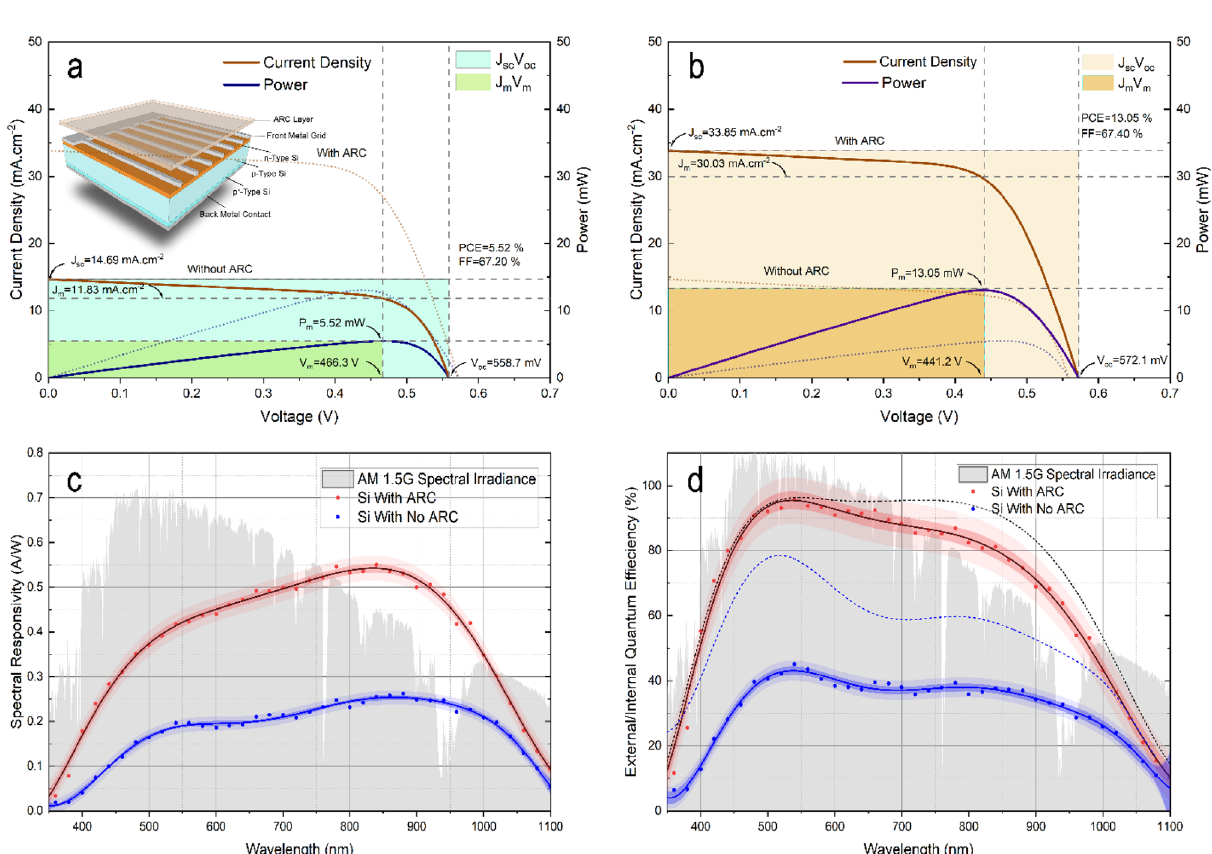
Figure 7. Optoelectrical performance of the crystalline silicon solar cell with and without CNx anti-reflective coating. ( a ) The current density–voltage curve of an uncoated c-Si solar cell. The inset is a schematic of the structure of the cell. ( b ) Current density–voltage curve of a CNx-coated c-Si solar cell. The dot lines for the uncoated c-Si solar cell. ( c ) Spectral responsivity for the c-Si solar cell with and without ARC of CNx. ( d ) The external/internal (dash lines) quantum efficiency of a c-Si solar cell with and without CNx anti-reflective